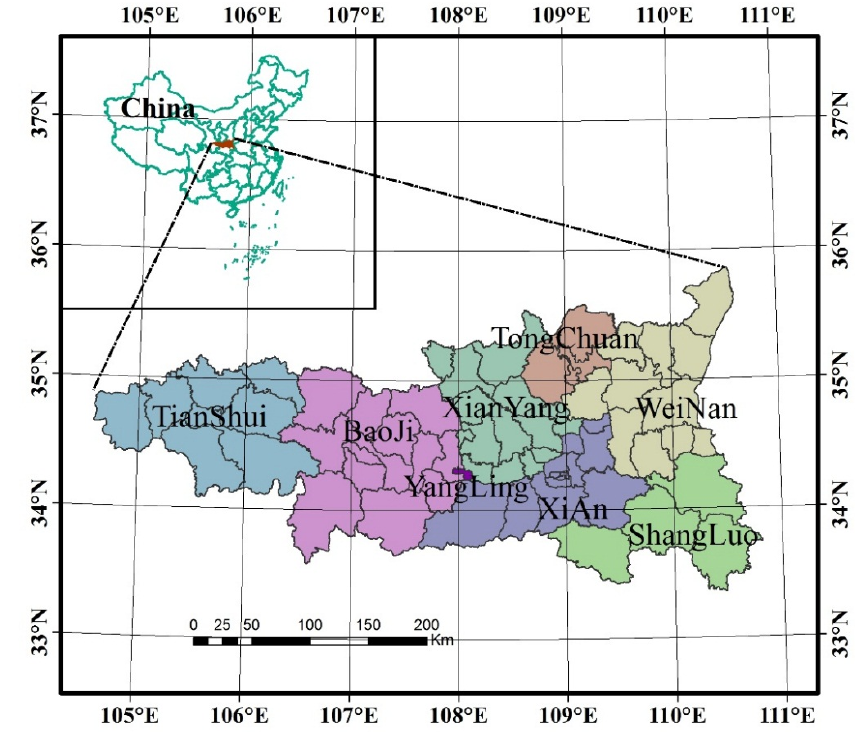
Figure 1. Administrative map of the study